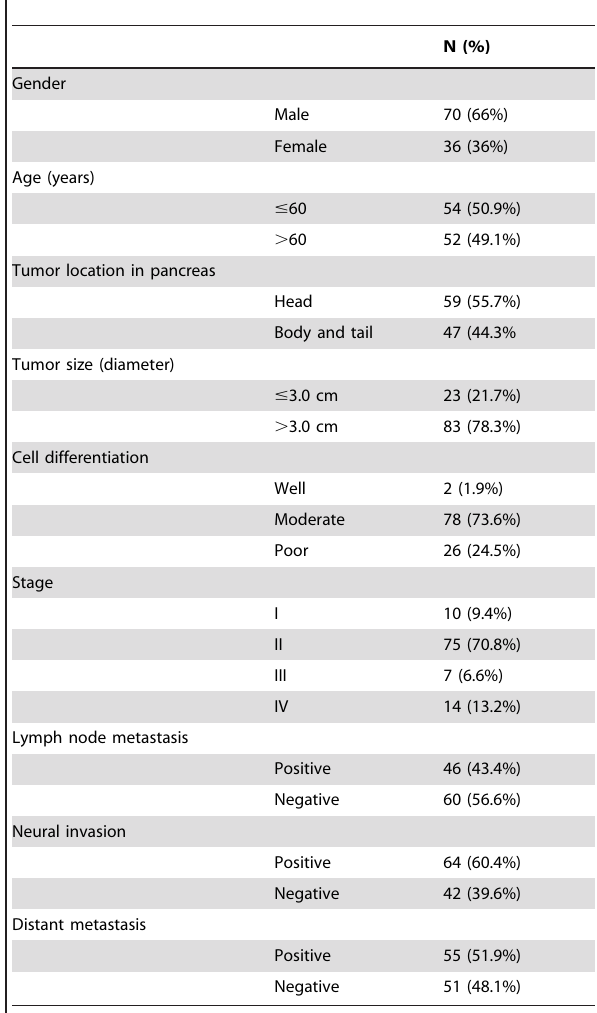
Table 2. The relationship between miR-26a expression and clinicopathological features in pancreatic